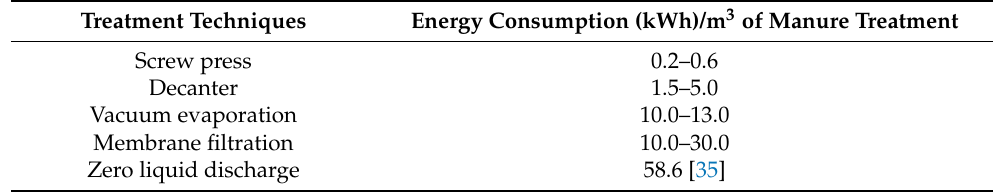
Table 1. Average energy consumption per m 3 of manure treatment [34]. Treatment